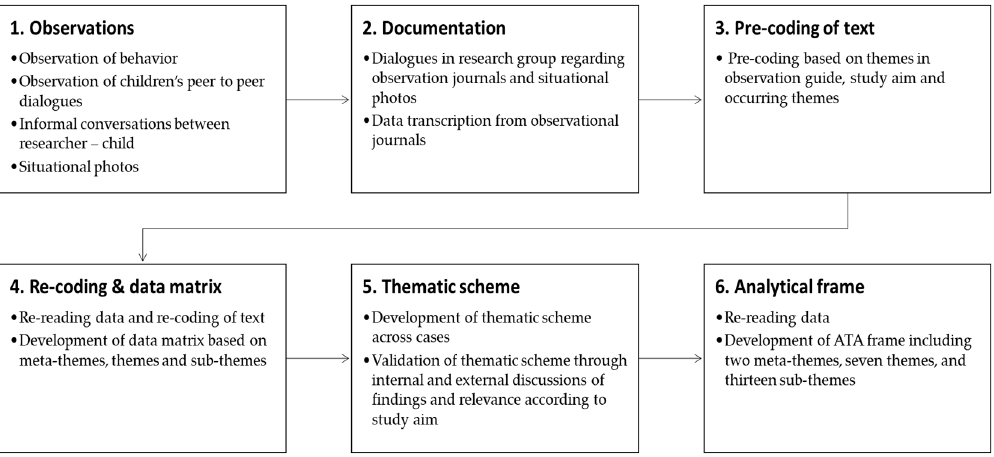
Figure 4. Overview of ATA data processing.